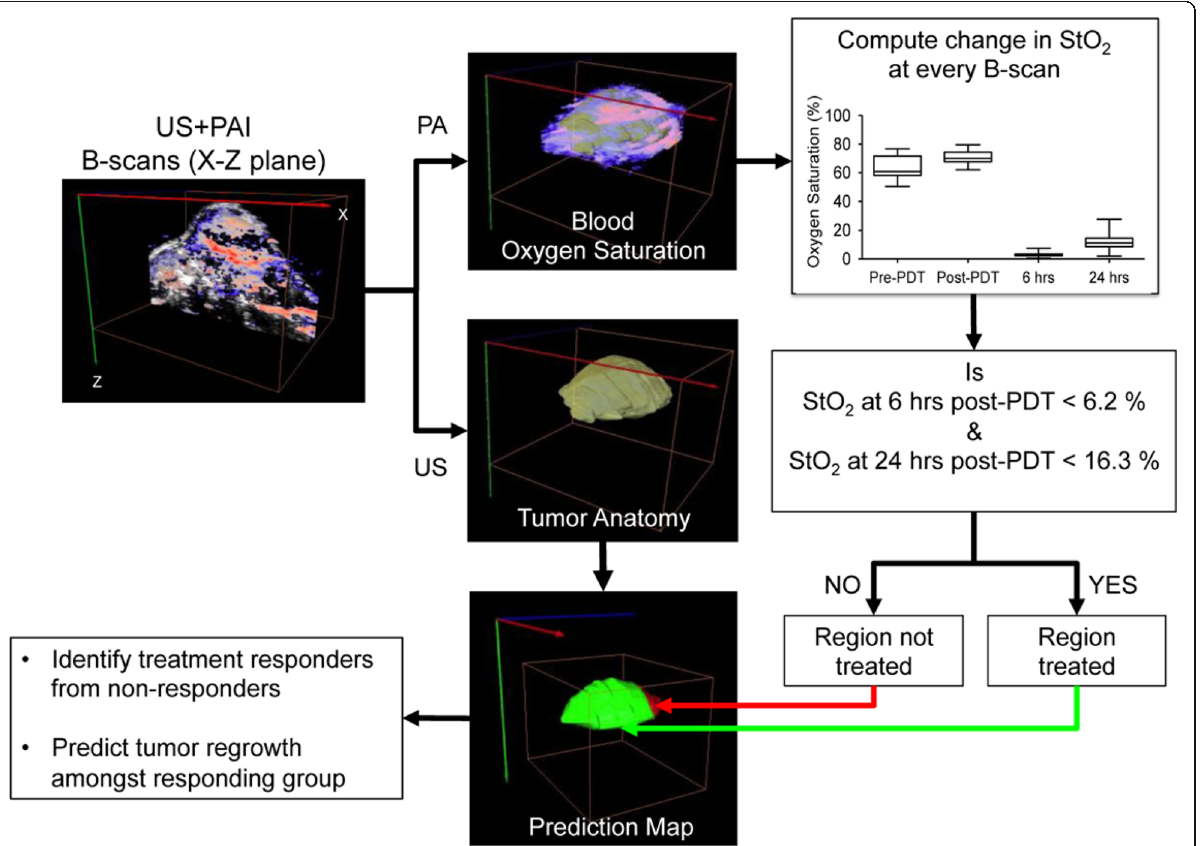
Fig. 8 Schematic algorithm to obtain PDT treatment prediction map from the US and PA images for identifying treatment responders from non- responders and for prediction of tumor regrowth